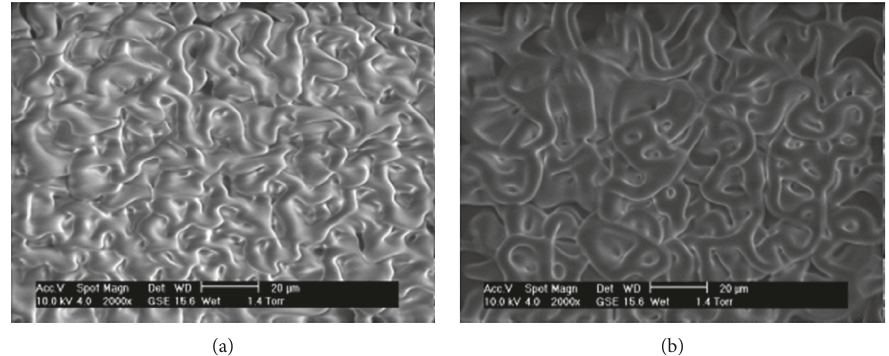
Figure 16: Figure micrograph of maltene fraction after irradiation for 1 minute (a) and after 2 minutes (b). The figure is obtained from Gaskin [44] (under the creative commons attribution license/public domain).